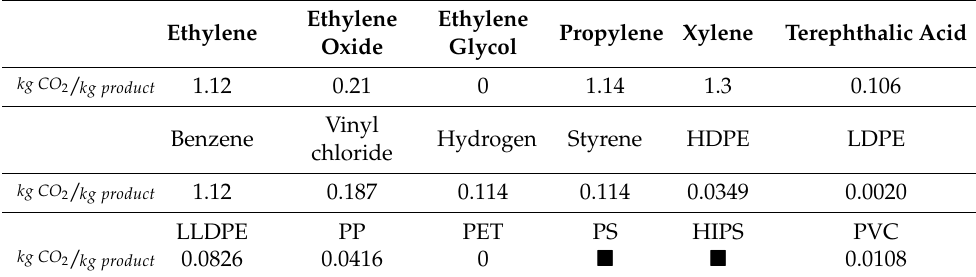
Figure 3. Energy consumption and CO 2 emissions for polyethylene and polypropylene production chains (data from the Ecoivent 3.6 dataset [56]). A detailed version is available in Appendix A. Table 1. Carbon dioxide emissions in the production of some typical feedstocks (data from the Ecoivent 3.6 dataset